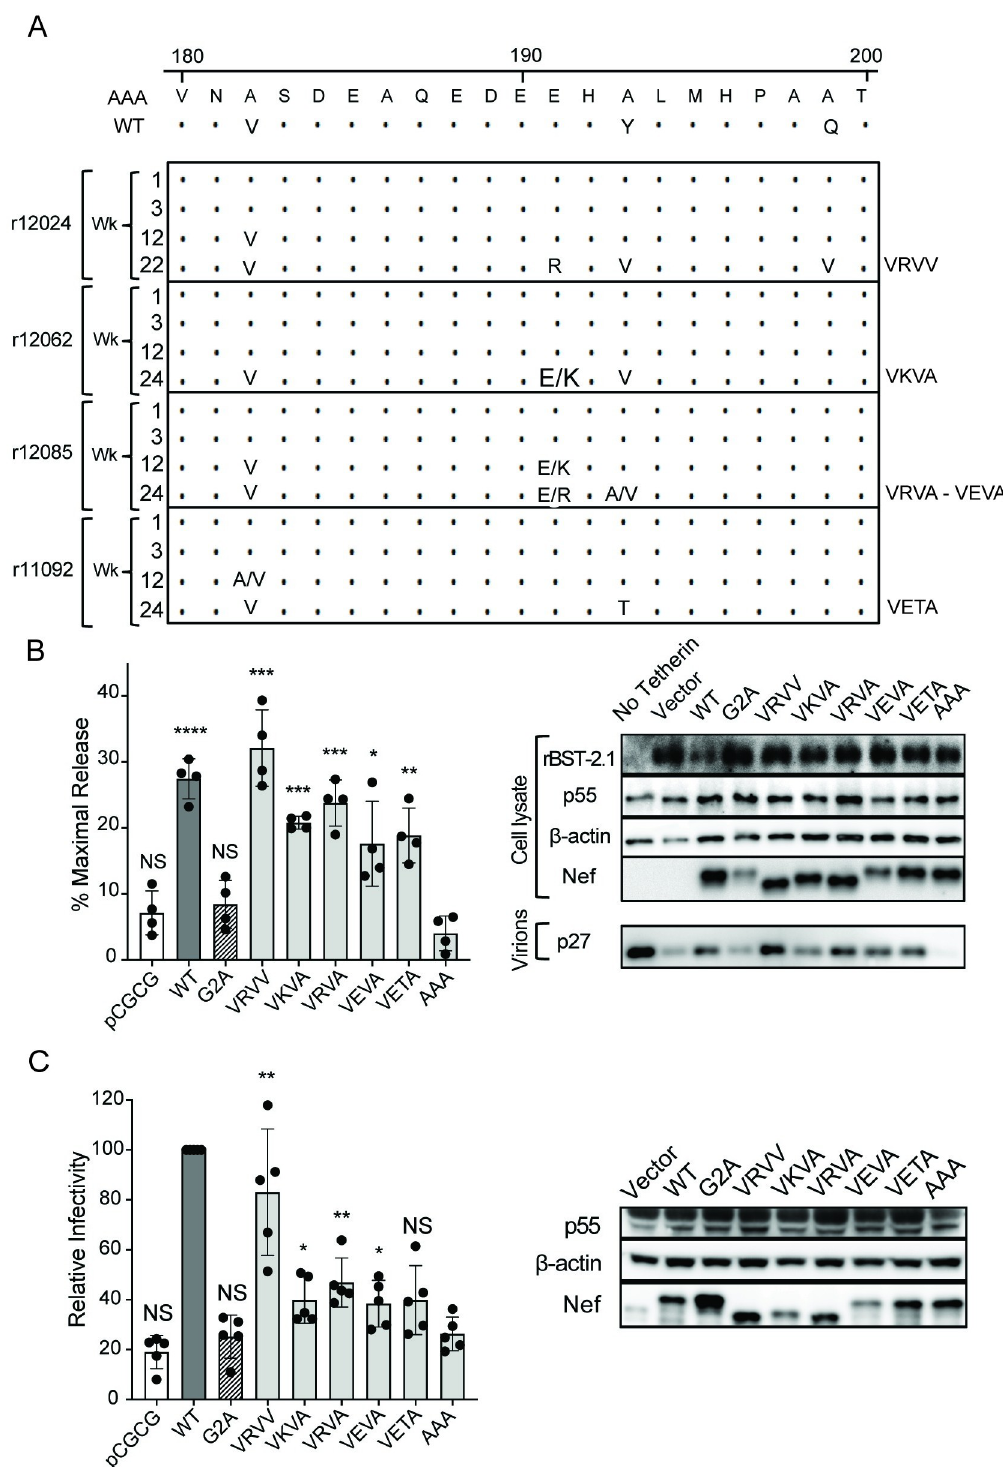
Fig 5. Sequence changes in Nef restore resistance to tetherin and SERINC5. (A) The virus population in plasma of animals infected with SIV mac 239 AAA was sequenced at the indicated time points post-infection. The predicted amino acid sequences in the flexible loop region of Nef are aligned to the corresponding Nef sequences of SIV mac 239 AAA and SIV mac 239. Positions of identity are indicated by periods and amino acid differences are identified by their single-letter code. (B & C) The Nef